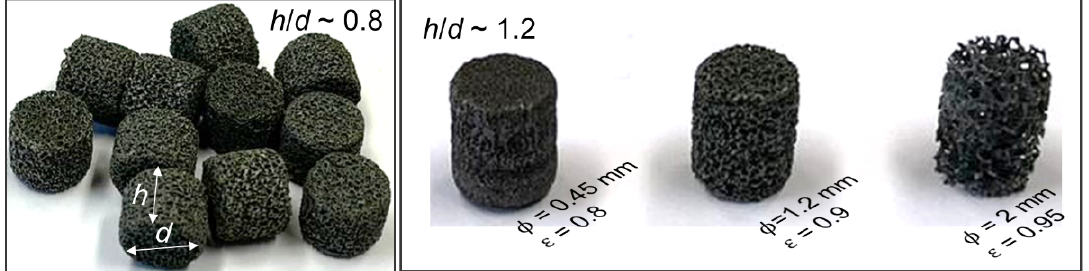
Figure 1. Metallic foam pellets—different sizes and morphology: cell size ( φ ) and porosity ( ε ). Slender packed bed reactors ( D / d p ≤ 10) are the preferred reactor type for an efficient removal or addition of heat, i.e., for highly exothermic or endothermic catalytic reactions. They have complex transport characteristics due to local bed structure effects [10], differ- ent flow regimes, and their interaction between different heat transfer mechanisms